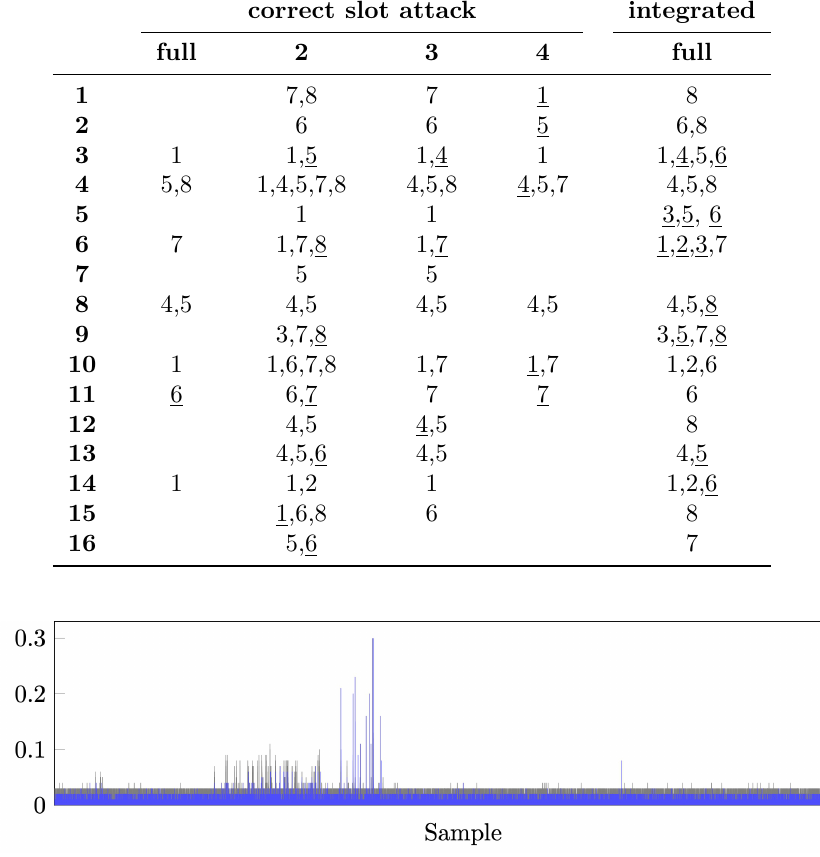
Figure 3: Correlation score when targeting at the 1 st bit in the 3 rd s-box with data- dependency integrated HO-DCA. The gray line is for the correct key byte 0xb3 and the blue lines are for the incorrect key